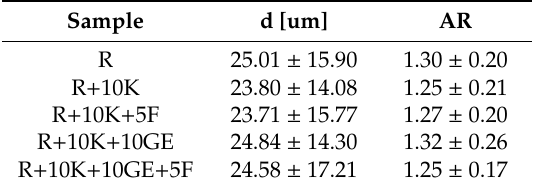
Table 9. Characteristic of the foam and composites